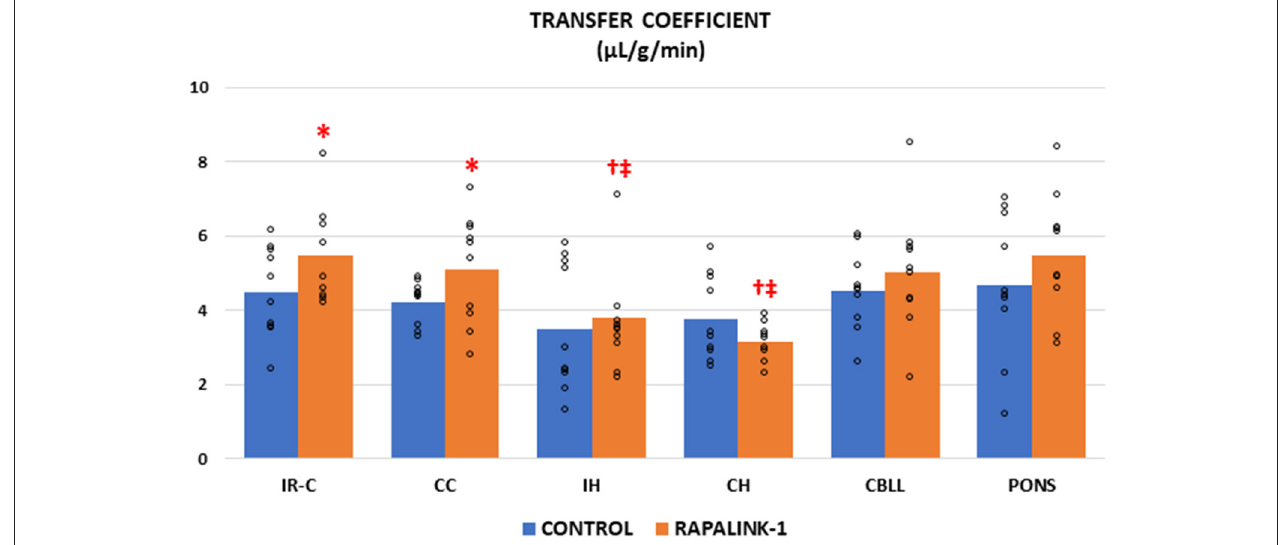
FIGURE 1 | Dot plots for the transfer coefficient (K i ) of 14 C-AIB in the examined brain regions of the control group [middle cerebral artery occlusion (MCAO)/reperfusion] and the Rapalink-1 group (MCAO/reperfusion + Rapalink-1) after 1h of MCAO and 2h of reperfusion. Each bar represents the mean value of each brain region. A two-way ANOVA followed by the Tukey’s test for multiple comparisons was used. The K i for 14 C-AIB was increased with Rapalink-1 in the IR-C and in the CC. n = 10 in each group. IR-C, ischemic-reperfused cortex; CC, contralateral cortex; IH, ipsilateral hippocampus; CH, contralateral hippocampus; CBLL,